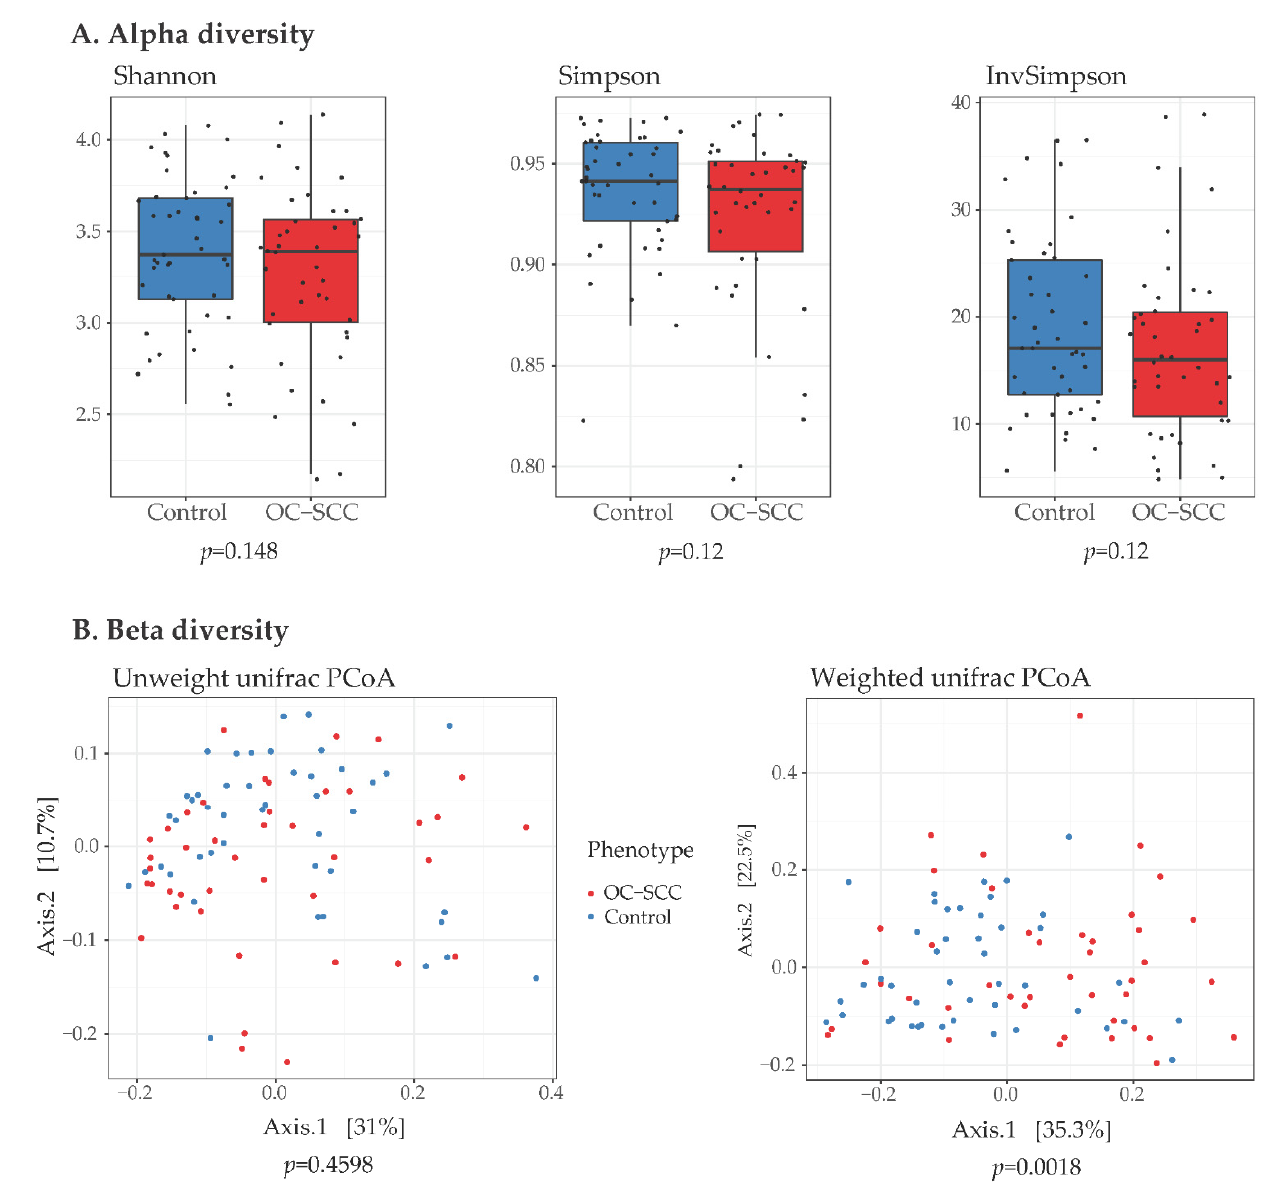
Figure 1. Comparison of alpha and beta diversity between nonsmoking oral cavity squamous cell carcinoma (OC-SCC) patients and non-OC-SCC control patients. ( A ) Boxplot of three types of alpha diversity: Shannon diversity, Simpson index, inverse Simpson index. P values were calculated by Mann–Whitney U test. ( B ) Principal coordinate analysis of the global differences of microbiome with unweighted and weighted UniFrac distances matrices. p values were calculated by Adonis test with 9999 permutations.